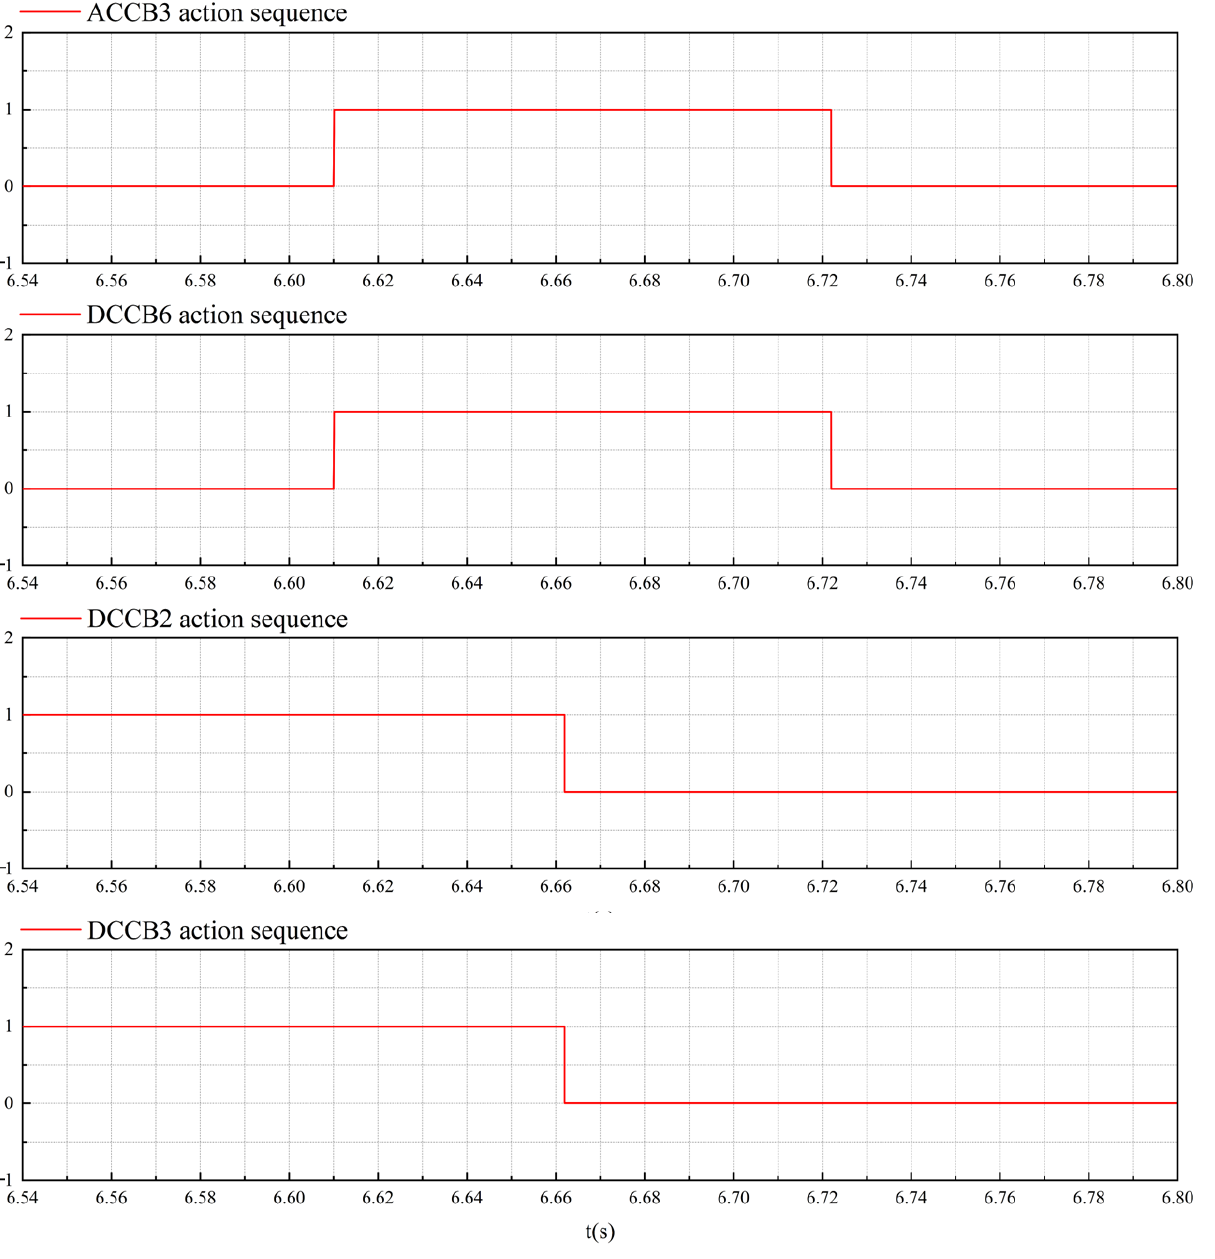
Figure 6. ACCB3, DCCB6, DCCB2, and DCCB3 action sequences.